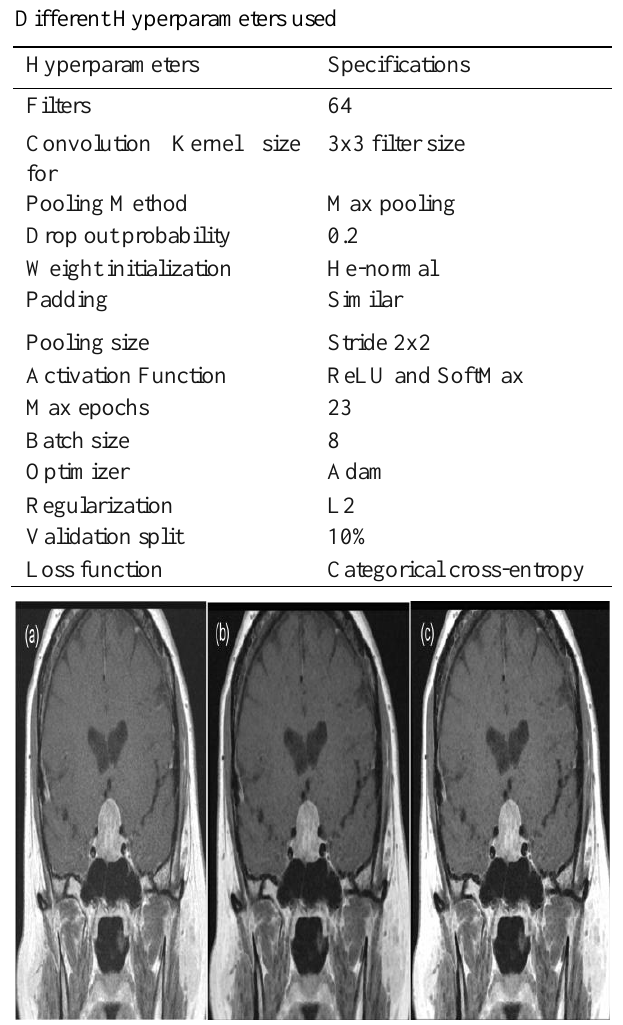
Fig. 5. Result of image processing steps (a) Raw image (b) Image with minimum filter (c) contrast Image Note: The Raw Image Brisque score is recorded as 70.46 and Pre- Processed Image Brisque score is